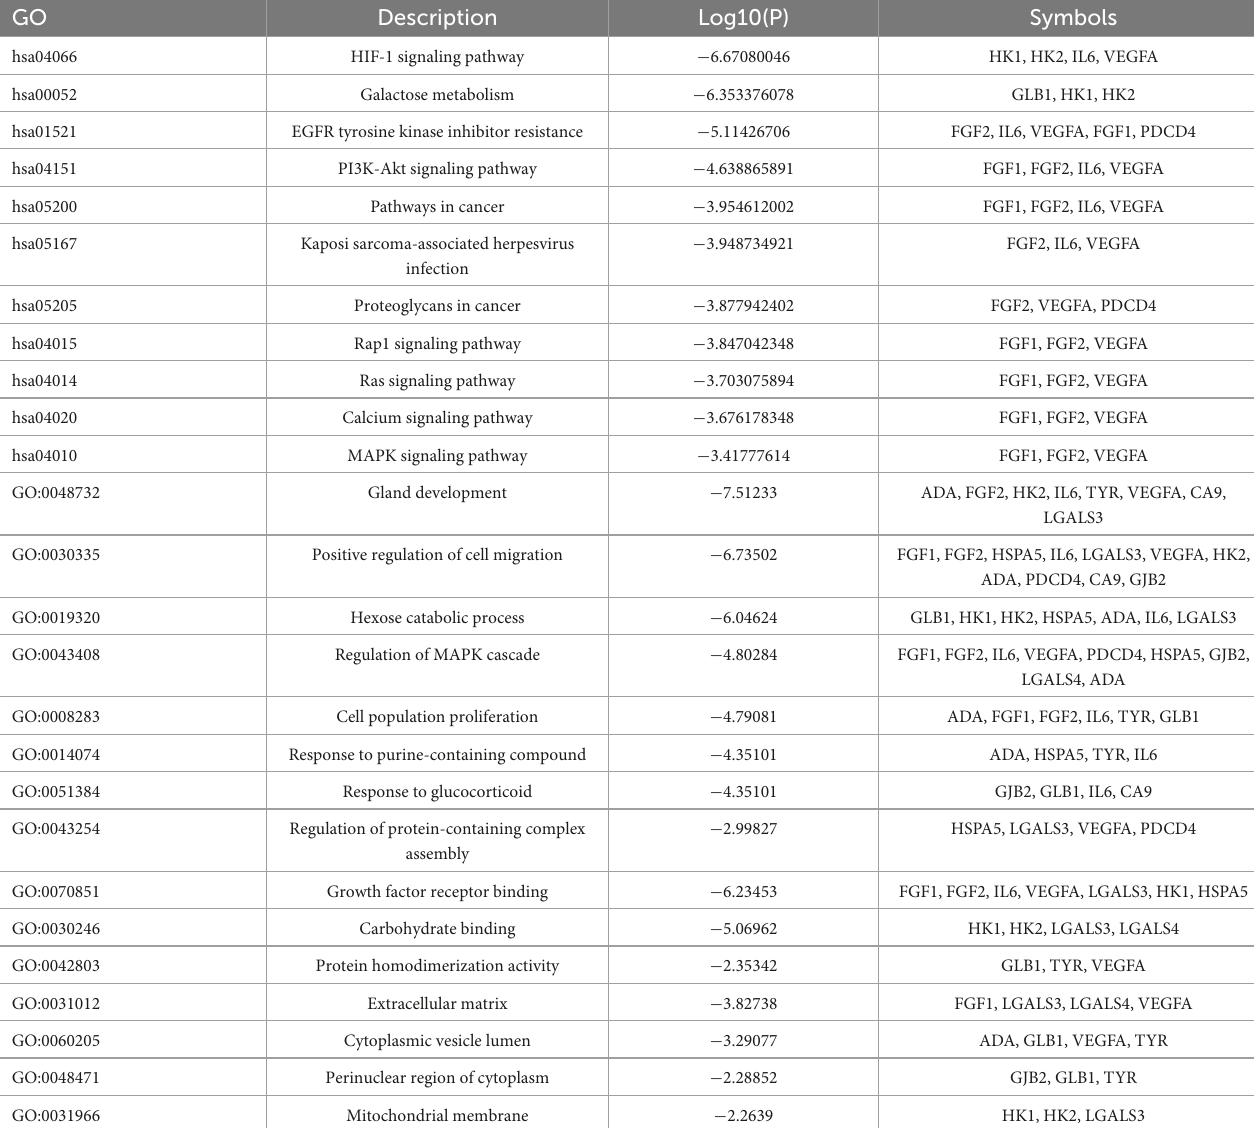
TABLE 3 Target pathway enrichment analysis results of seabuckthorn polysaccharides for prevention and treatment of cervical cancer.